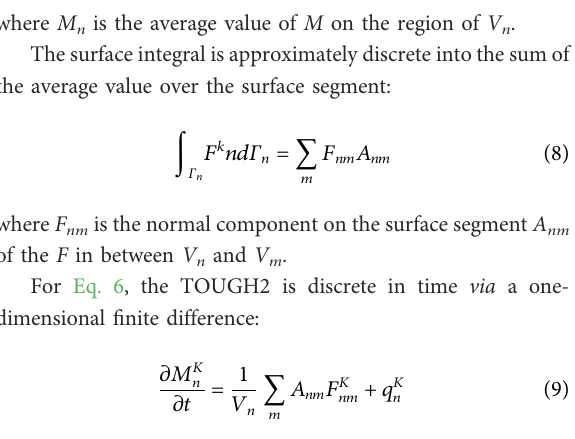
FIGURE 4 The monthly average monitoring data. (A) climate data, (B) temperature